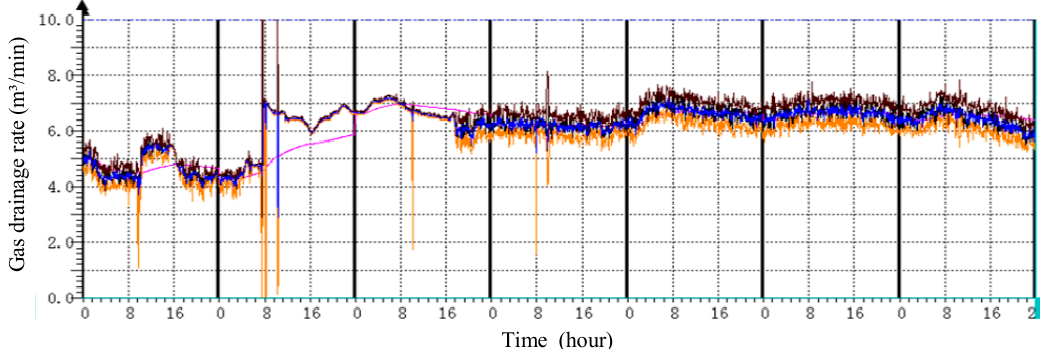
Figure 15. Curve variation in extraction rate before and after deep-hole blasting.